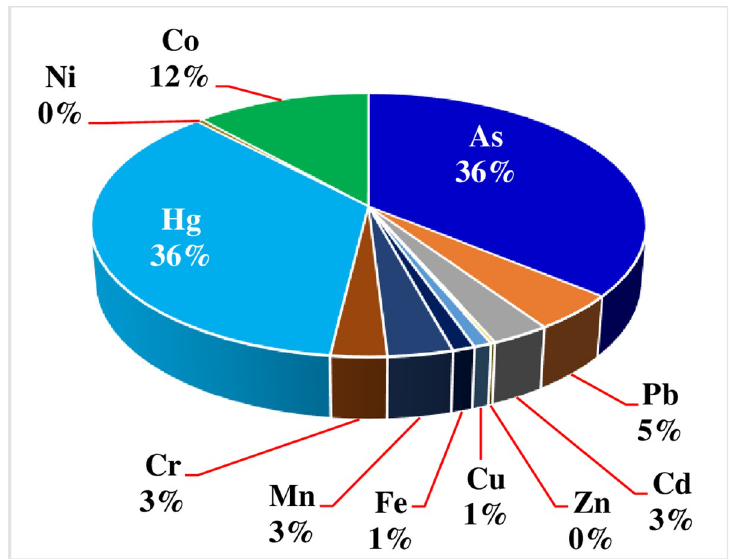
Fig 3. Percentage contribution of each metals to the total